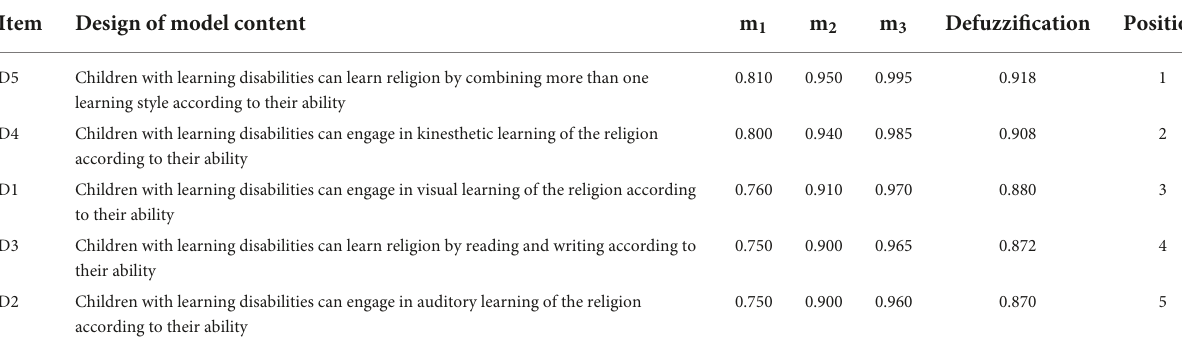
TABLE 8 Fuzzy evaluation of construct four: Learning style for children with learning disabilities.